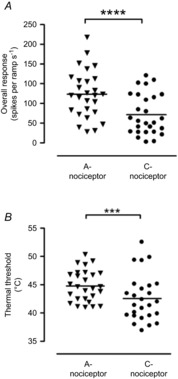
Responses of dorsal horn neurons to thermal activation of A- and C-nociceptors are significantly differentA, the magnitude of overall responses of class 2 deep dorsal horn neurons to activation of A-fibre nociceptors was greater than that to activation of C-fibre nociceptors. B, thermal thresholds for A-nociceptor activation were significantly higher than for C-nociceptor activation. ***P = 0.0065, ****P < 0.0001, paired Student's t test.